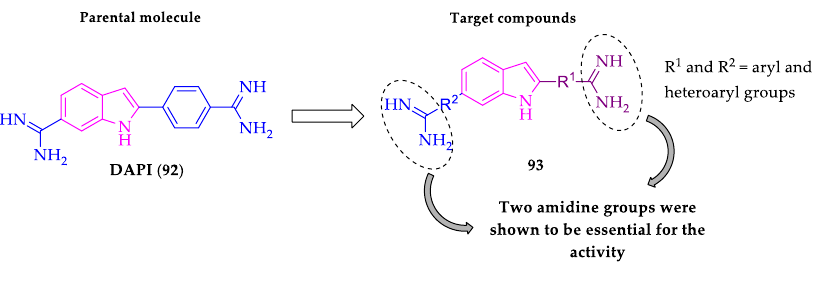
Figure 11. SAR for DAPI analogs 93 .